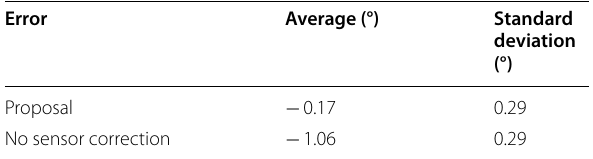
Table 3 Error of estimated roll angle (Urban